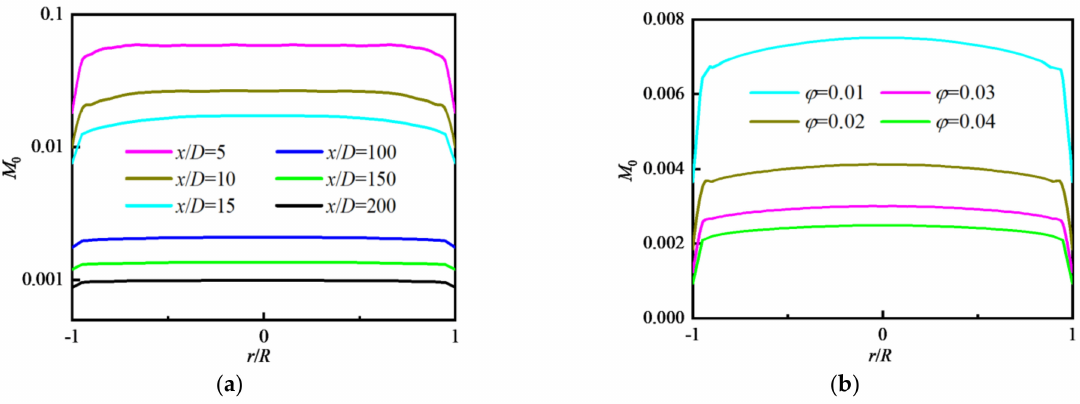
Figure 8. Distribution of M 0 along the radial direction with different ϕ (Re = 9194): ( a ) ϕ = 0.04; ( b ) x/D =